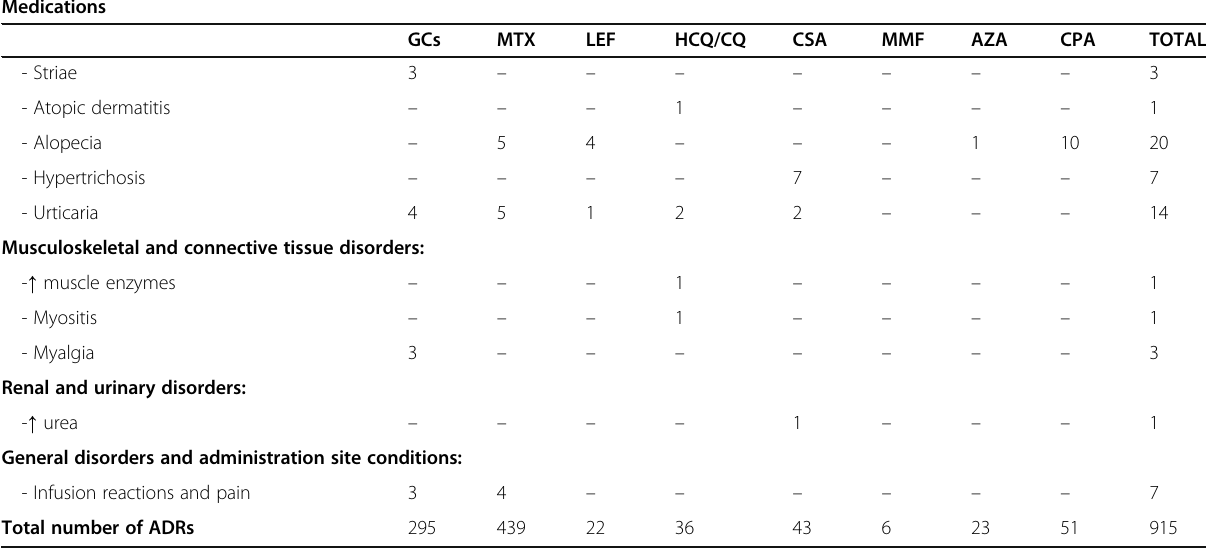
Table 1 ADRs of glucocorticoids and synthetic DMARDs in patients with JIA, JSLE and JDM (Continued) Medications